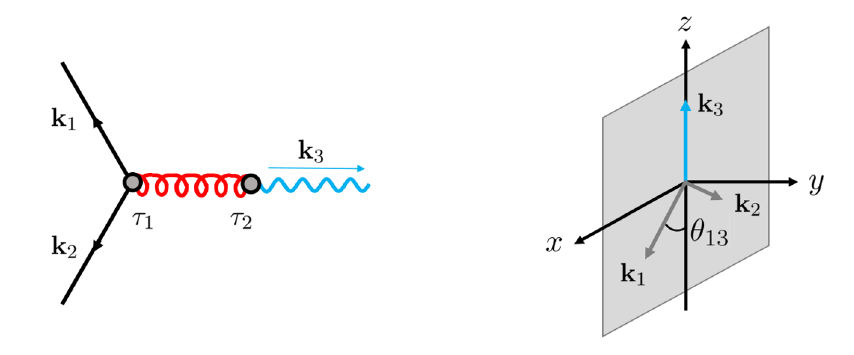
Figure 3 . Left: the leading-order contribution of the amplified massive spin-2 field to h ζζγ i . Right: the kinematic